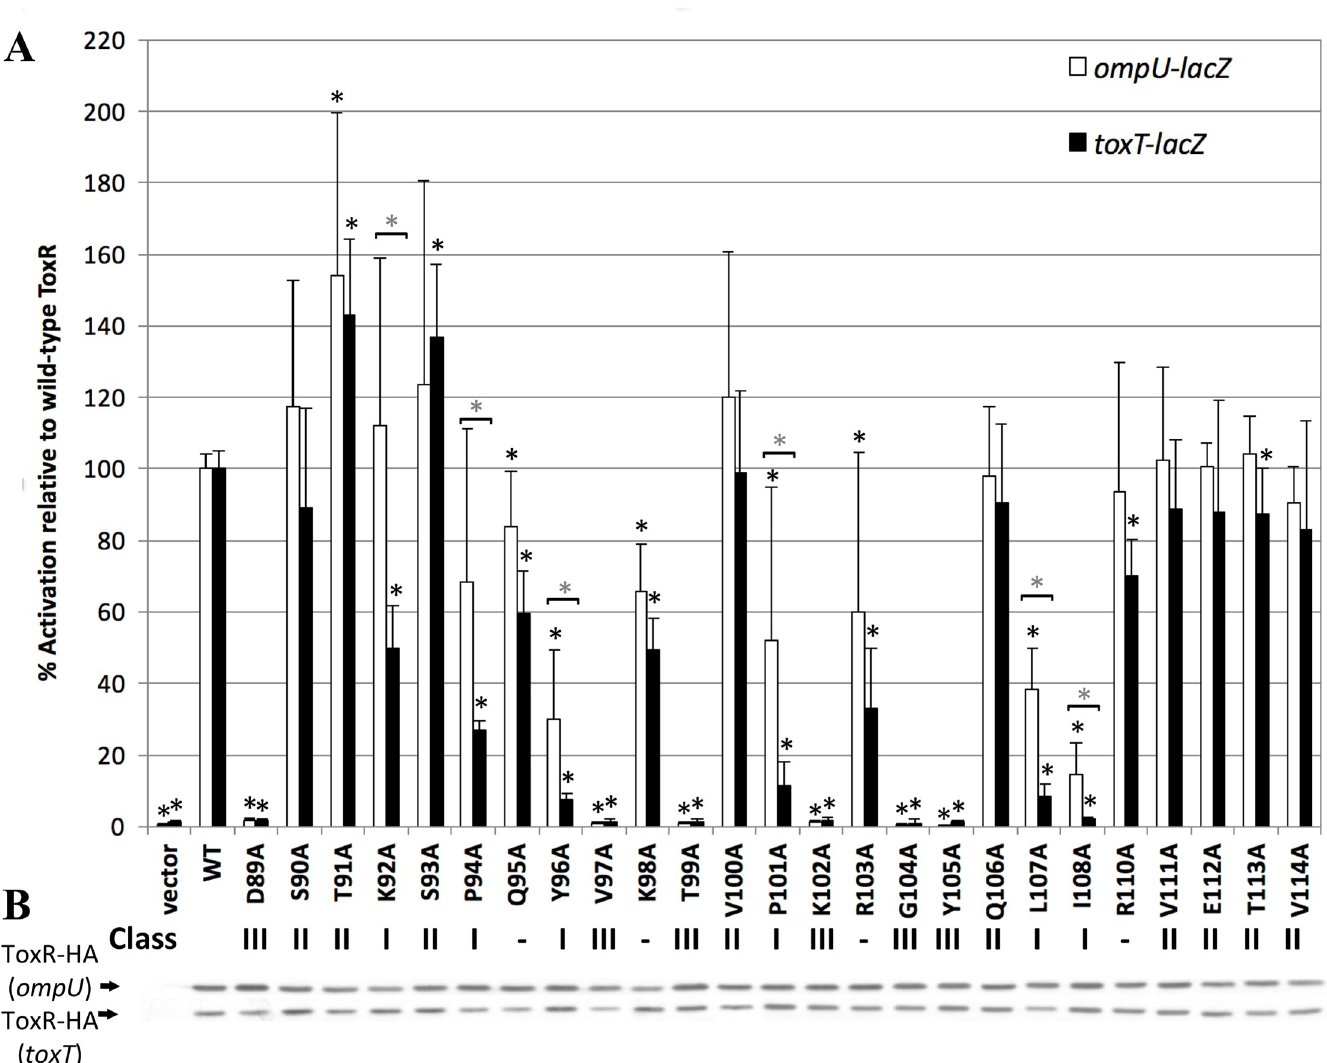
Fig 2. Requirement of each residue in the ToxR wing on toxT and ompU activation. A) ToxR-HA wing mutants were expressed from pBluescriptSK- (pSK) in the presence of pREP4 to regulate expression. The level of activation both the toxT-lacZ and ompU-lacZ chromosomal reporters for each mutant was measured by β - galactosidase assay and normalized to wild-type ToxR. � p < 0.001923 using the Students’ T-test and a cut-off for significance at 0.05/26 according to the Bonferroni correction for multiple comparisons. � above a [indicates ToxR mutants that are at least 2-fold more defective for toxT activation than ompU activation. � p < 0.05 using the Students’ T-test. B) Stability of ToxR-HA was monitored by Western blot using a monoclonal anti-HA. All strains were tested at least six times on at least two different days. Where appropriate, the mutant class is listed below each substitution. ToxR-Q95A, ToxR-K98A, ToxR-R103A, and ToxR-R110A did not fit into any of the mutant class